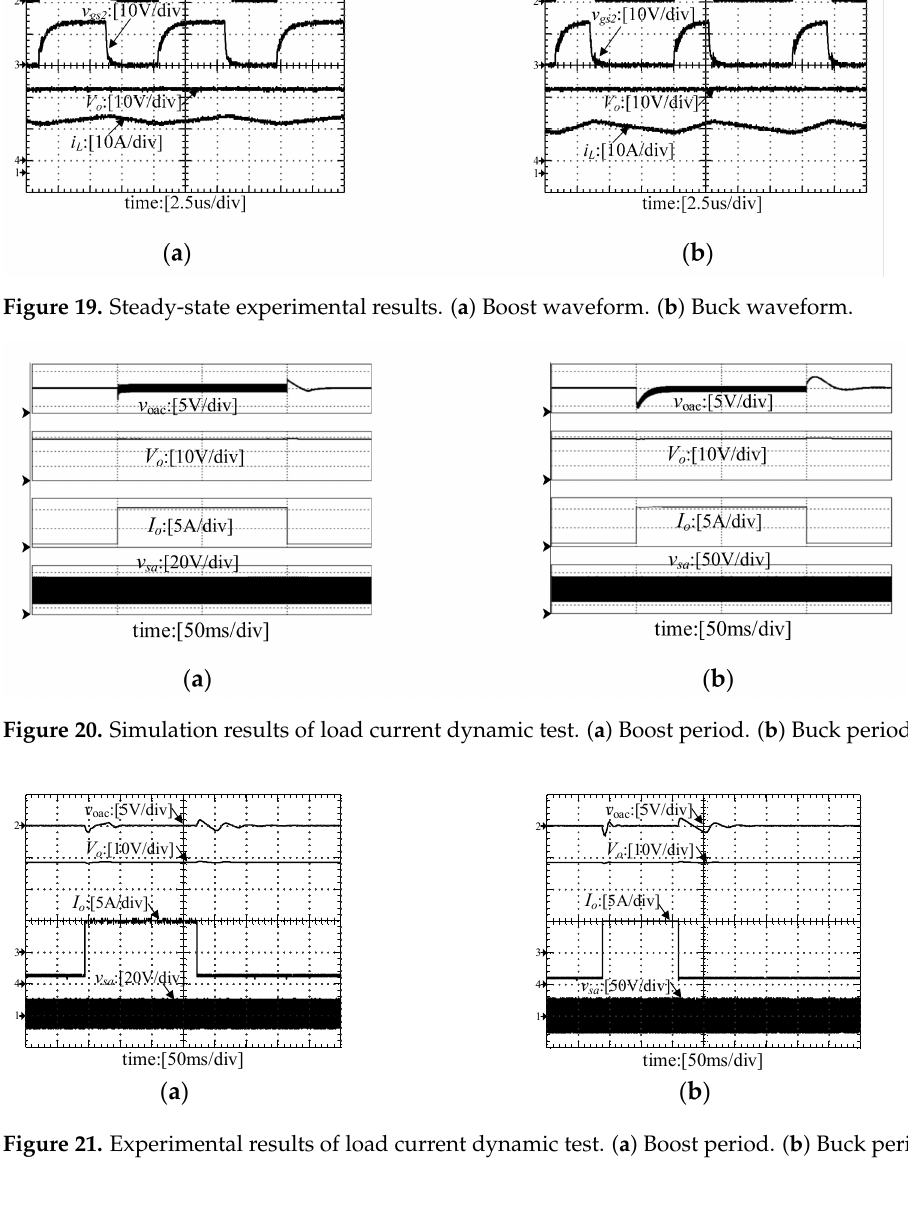
(b) Figure 22. Simulation results of input voltage dynamic test. (a) Without IVFF. (b) With IVFF. (a) (b) Figure 23. Experimental results of input voltage dynamic test. (a) Without IVFF. (b) With IVFF. Figure 24 is the efficiency curve. The AC - DC converter has high efficiency in the three-phase line voltage between 5 ~ 50 V.